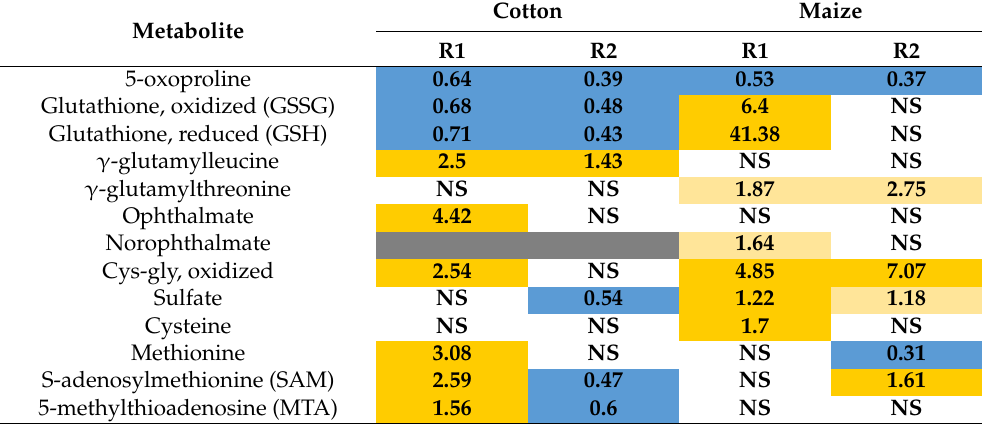
Table 3. Ratios of abundance of metabolites involved in sulfur and glutathione metabolism in R1 and R2 of the elongation zone of water-stressed compared with well-watered primary roots of cotton and maize. Metabolite